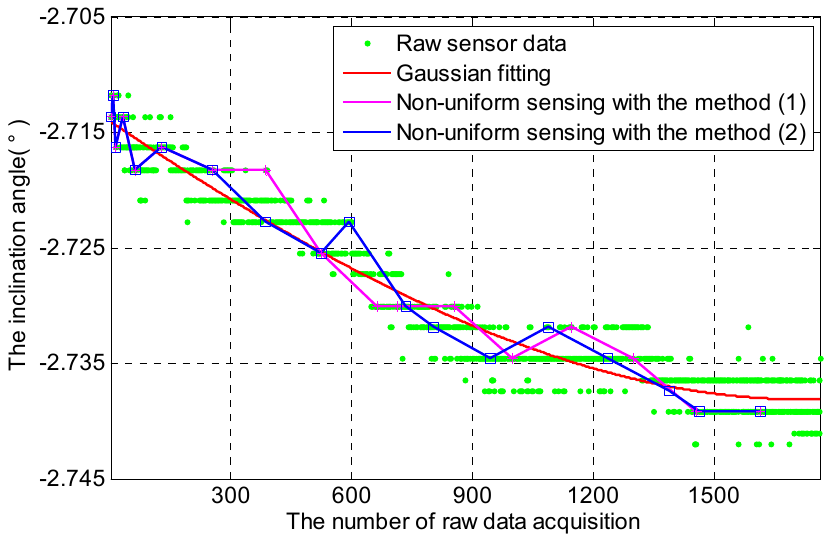
Figure 11. Non-uniform sensing with cooperative TDSS under two methods of calculating ∆ V.